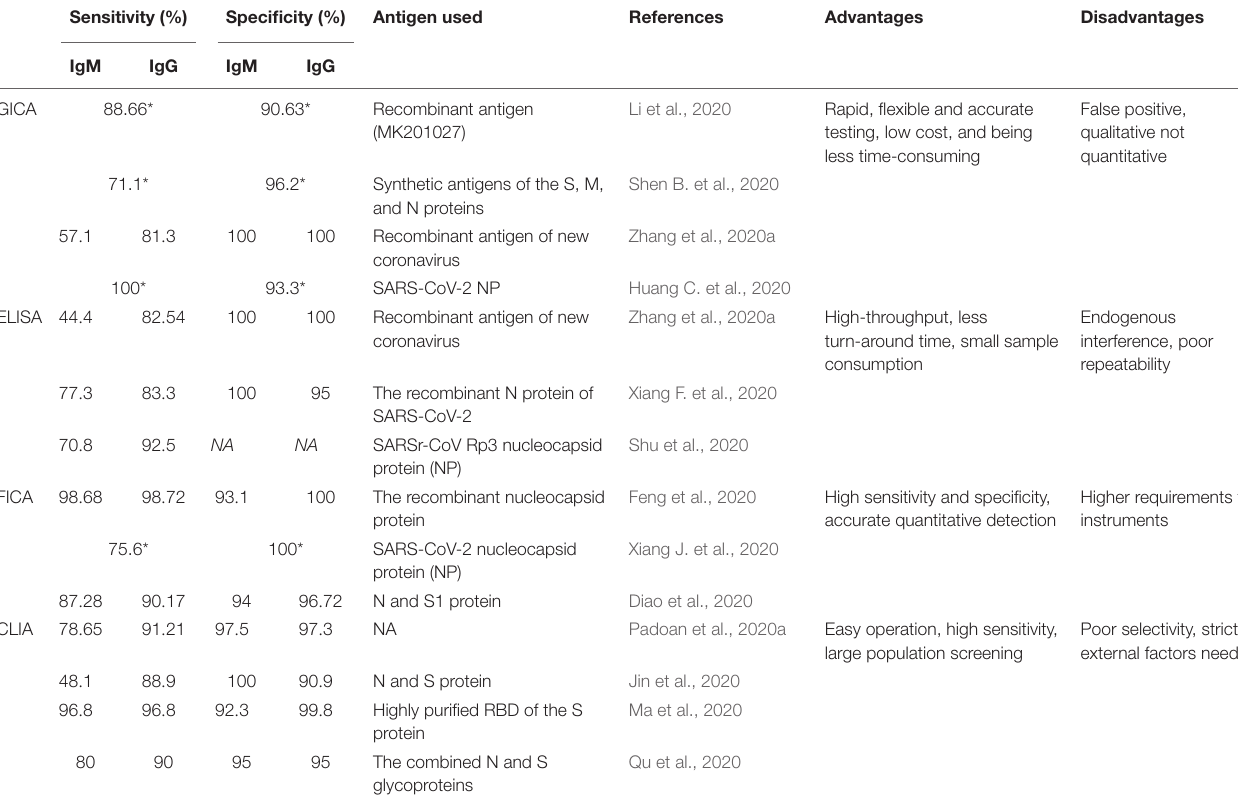
TABLE 1 | The sensitivity and specificity of IgM and IgG detection in different serological tests. Sensitivity (%) Specificity (%) Antigen